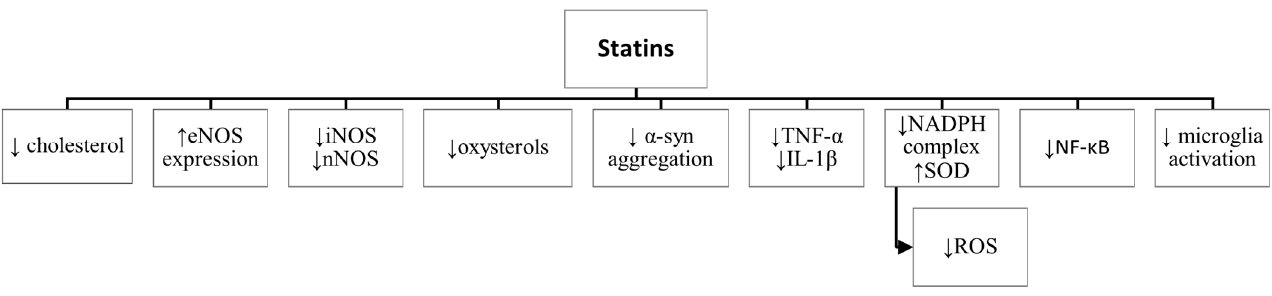
Figure 1. Neuroprotective mechanisms of statins. ↑ —increase, ↓ —decrease, eNOS—endothelial nitric oxide synthase, iNOS—inducible nitric oxide synthase, nNOS—neuronal nitric oxide synthase, α -syn—alpha-synuclein, TNF- α —tumor necrosis factor-alpha, IL-1 β —interleukin-1beta, NADPH—nicotinamide adenine dinucleotide phosphate, SOD—superoxide dismutase, ROS—reactive oxygen species, NF- κ B—transcription nuclear factor-kappaB.